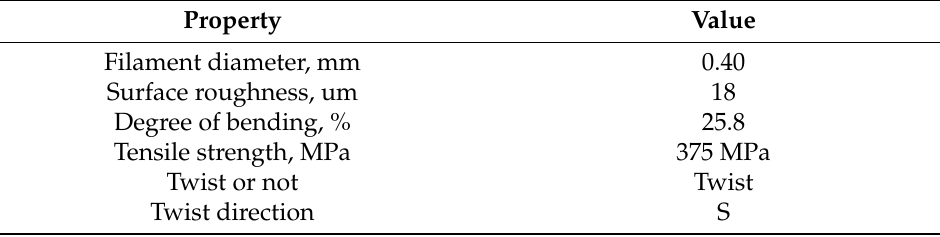
Table 2. CFRTPCFs material parameters [36].